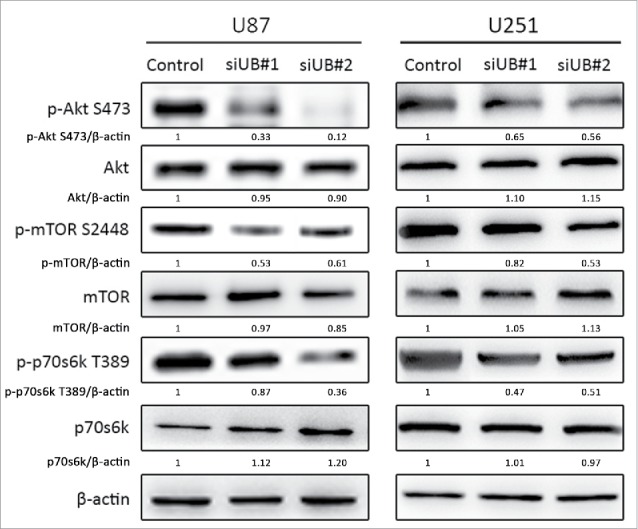
si-UBE2C inhibits the PI3K-Akt-mTOR signaling pathway in glioma cells. U87-MG and U251 cells were transiently transfected with si-UBE2C for 48 h, and the expression of phospho-Akt, phospho-mTOR and phospho-p70S6K1 was then analyzed by Western blot. β-Actin was used as a loading control.